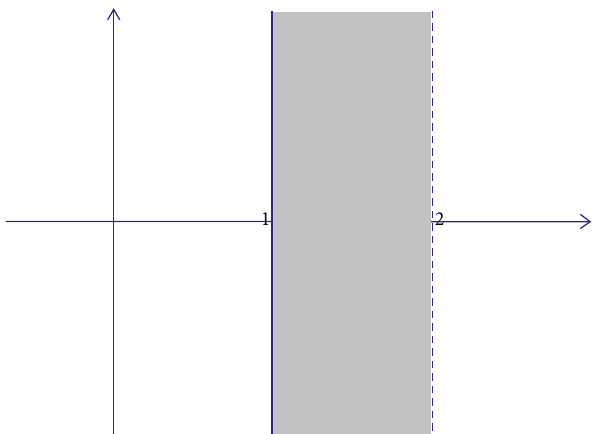
Figure 1: Zero-free region for hypergeometric zeta function of order N